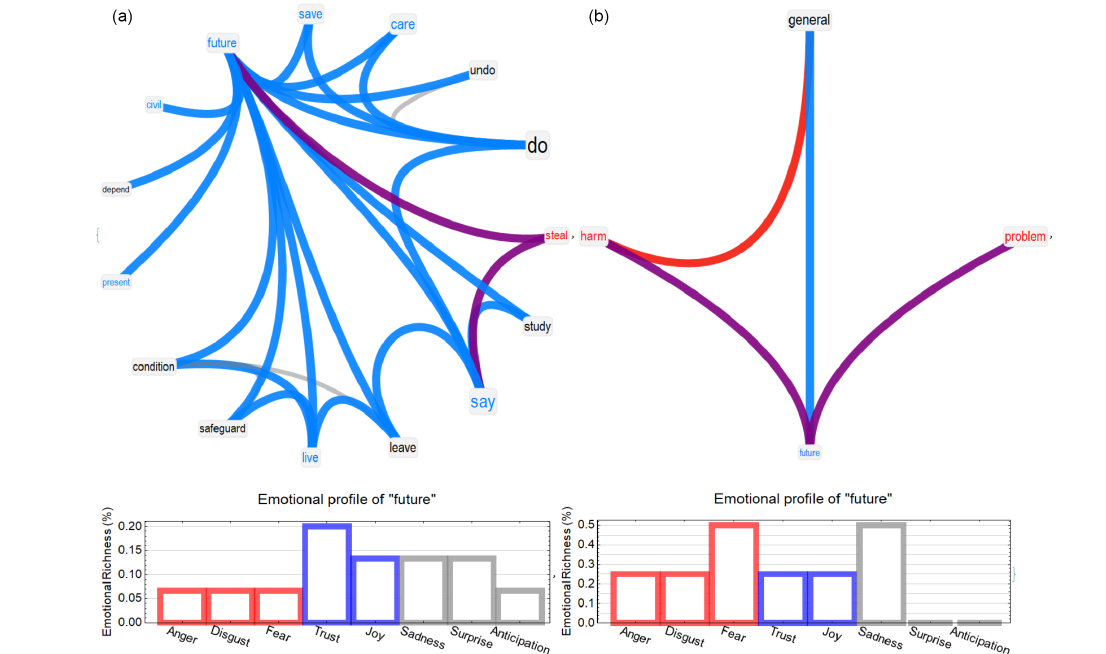
Figure A8. Speakers’ mindset reconstruction around “future” in the speeches of Greta Thunberg (a) and Christopher Monckton (b) . We refer the reader to Fig. 1 for a detailed explanation of the colour code and to Lexicon 1 for an interpretation of the figure.